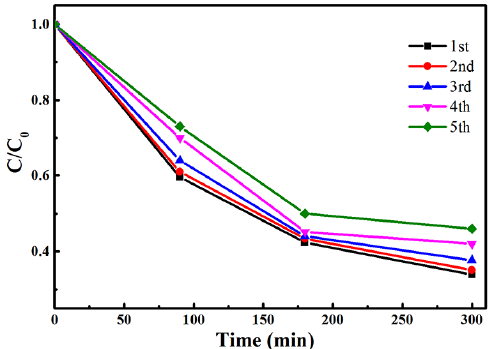
Figure 9. Cycling runs for the photoreduction of Cr(VI) by CN-2/ZnO composite under visible light.